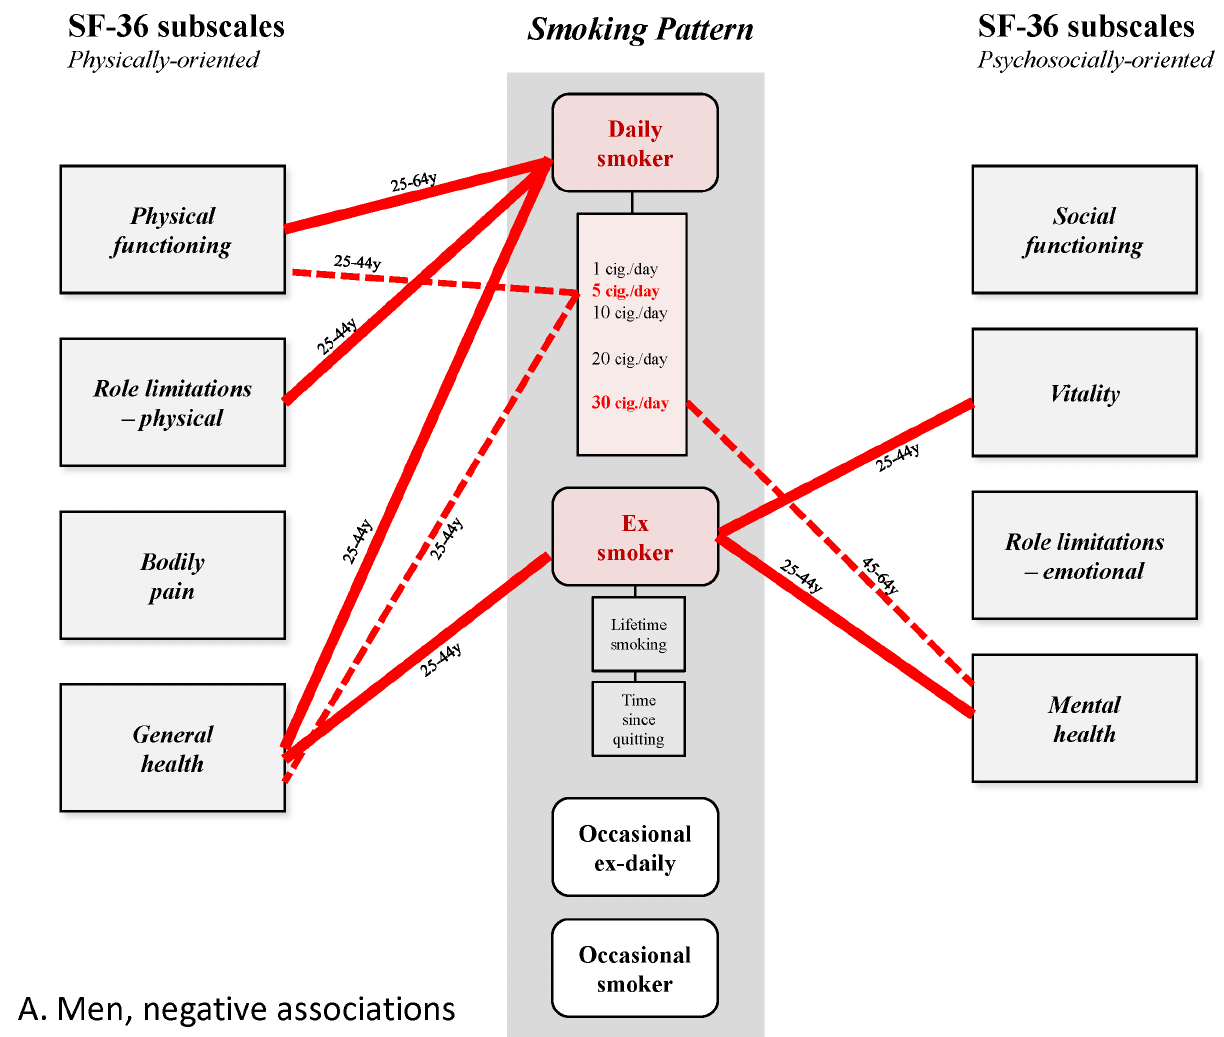
Figure 4. Patterns of relationships found in this study. Men, positive associations.